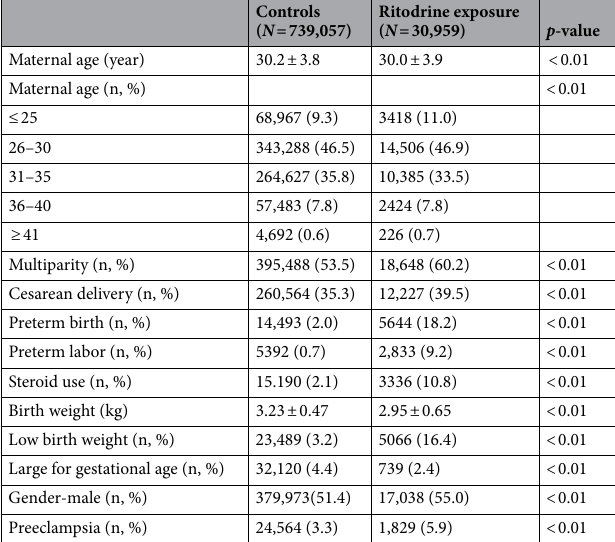
Table 1. Clinical characteristics of the mothers with and without ritodrine exposure. Data presented is n (%) or mean (standard